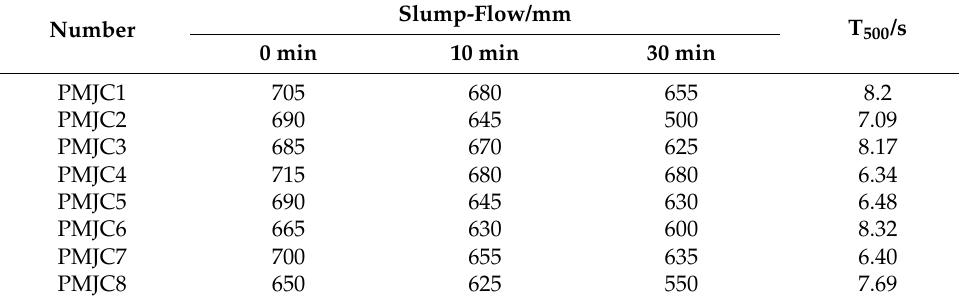
Table 5. Slump-flow and T 500 .